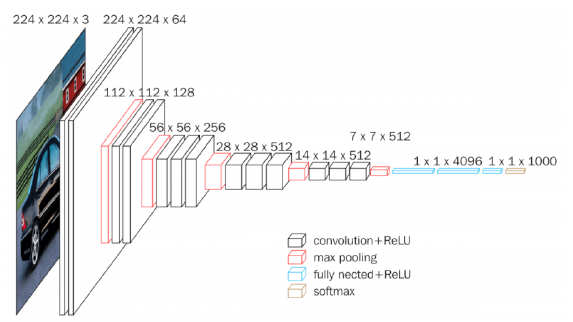
Figure 4. Detailed architecture of VGG16 neural network